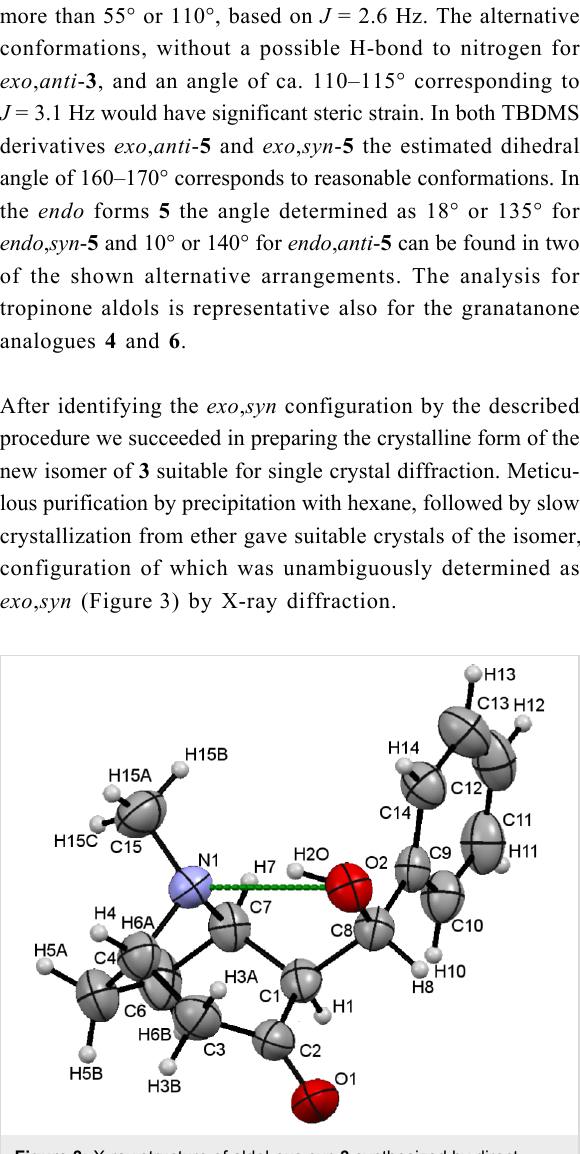
Figure 3: X-ray structure of aldol exo , syn - 3 synthesized by direct, solventless reaction of tropinone with benzaldehyde in the presence of catalytic amounts of water, showing an intramolecular H-bond: N1 … O2 2.763(2), N1 … H 1.920(2) Å, N1 … H2O … O2 angle 151(2)°. Displace- ment ellipsoids are drawn at 30% probability level; atom numbering is